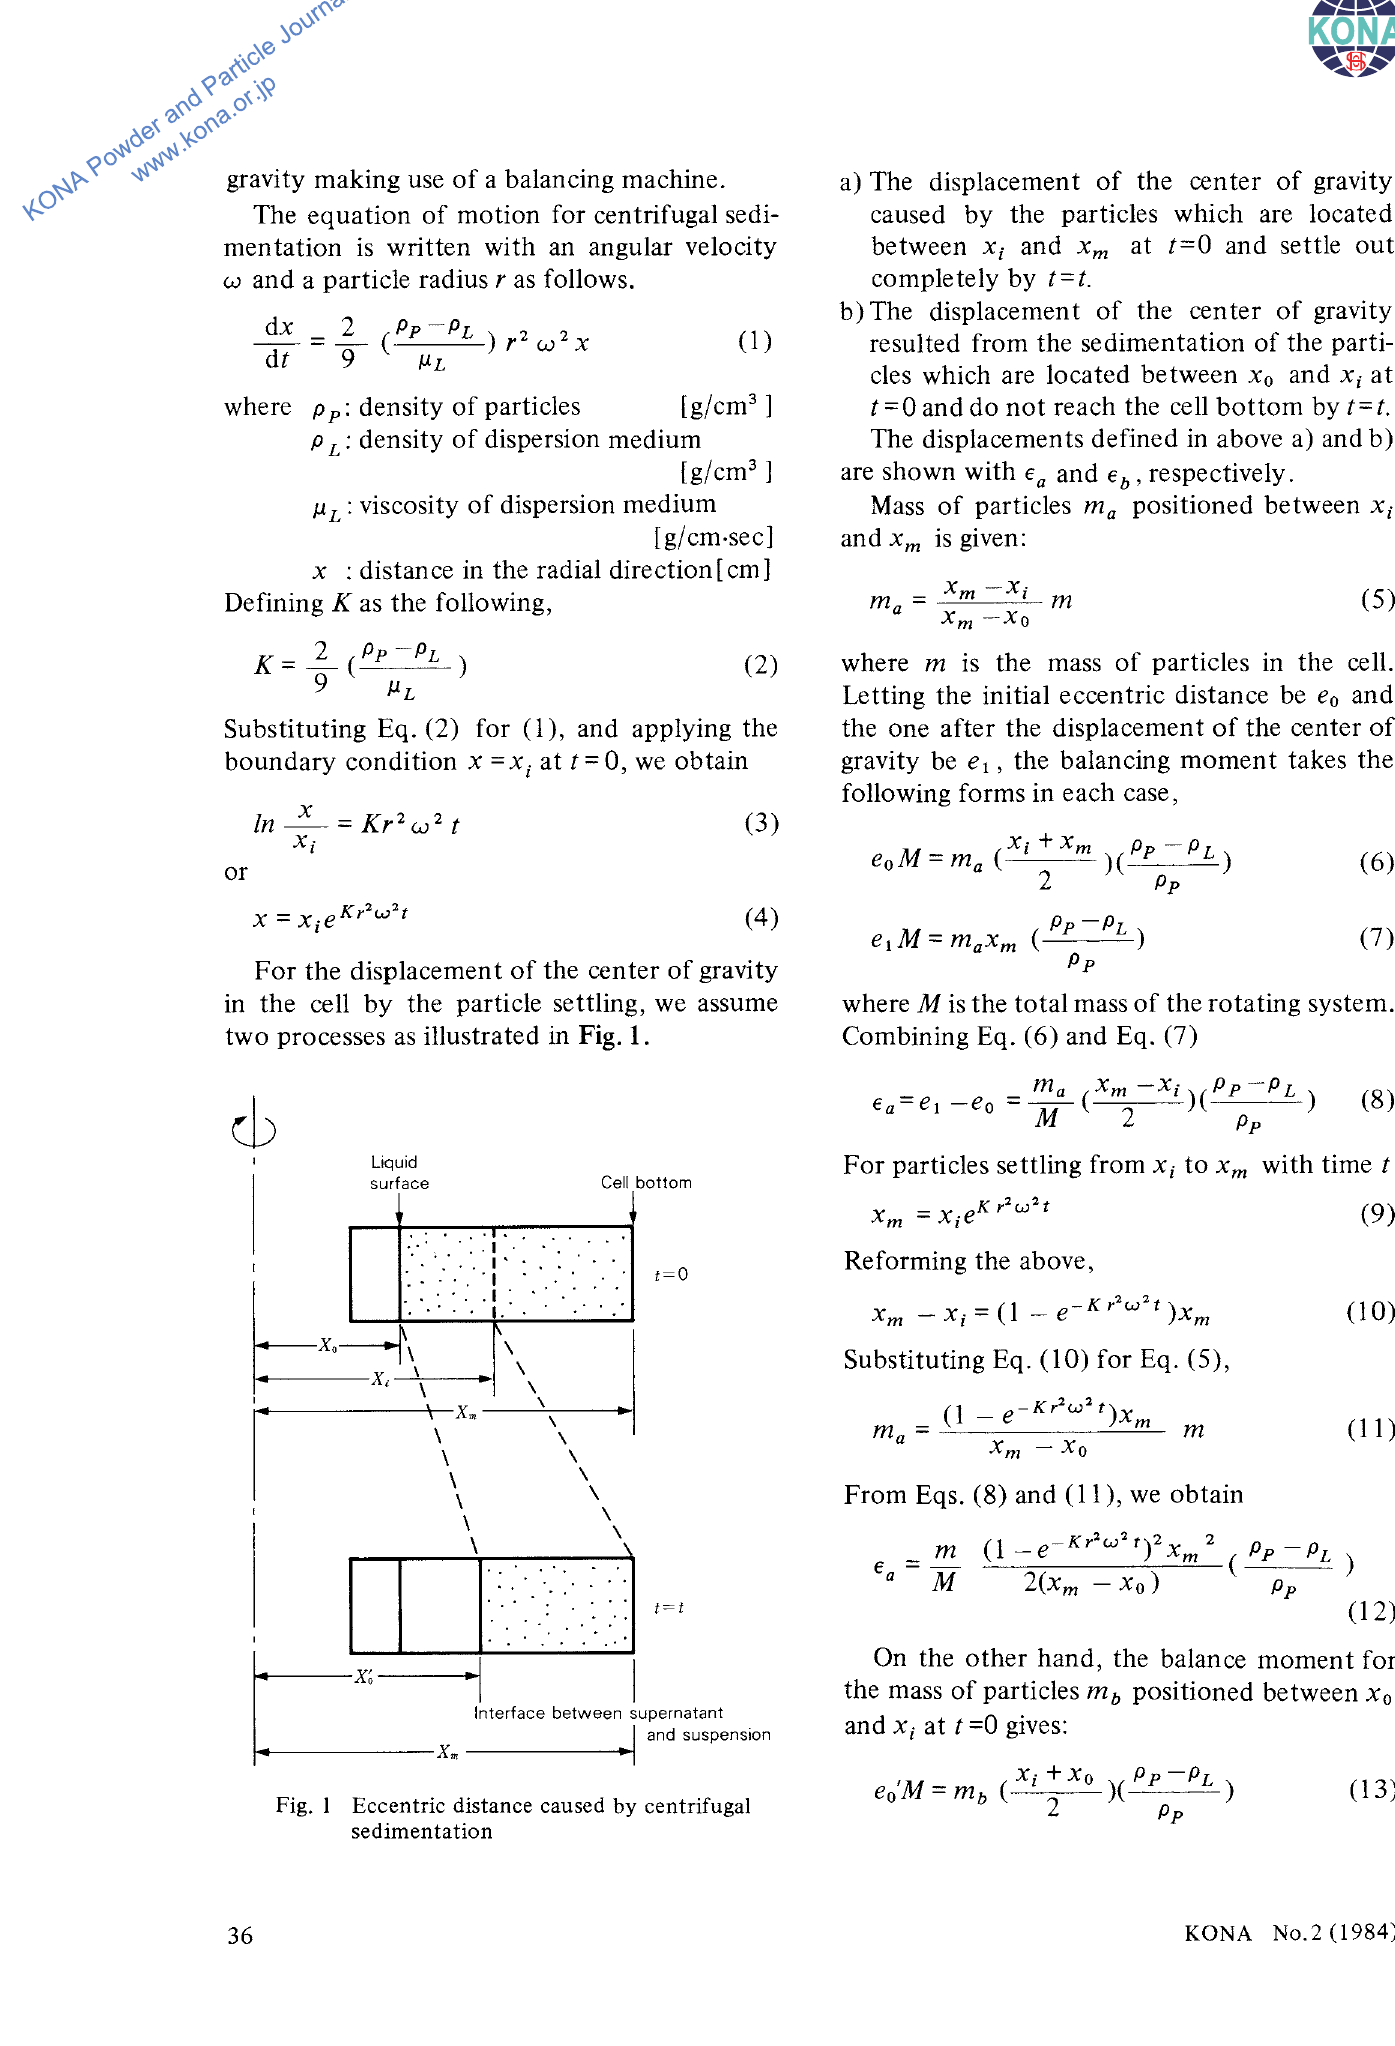
Fig. 1 Eccentric distance caused by centrifugal